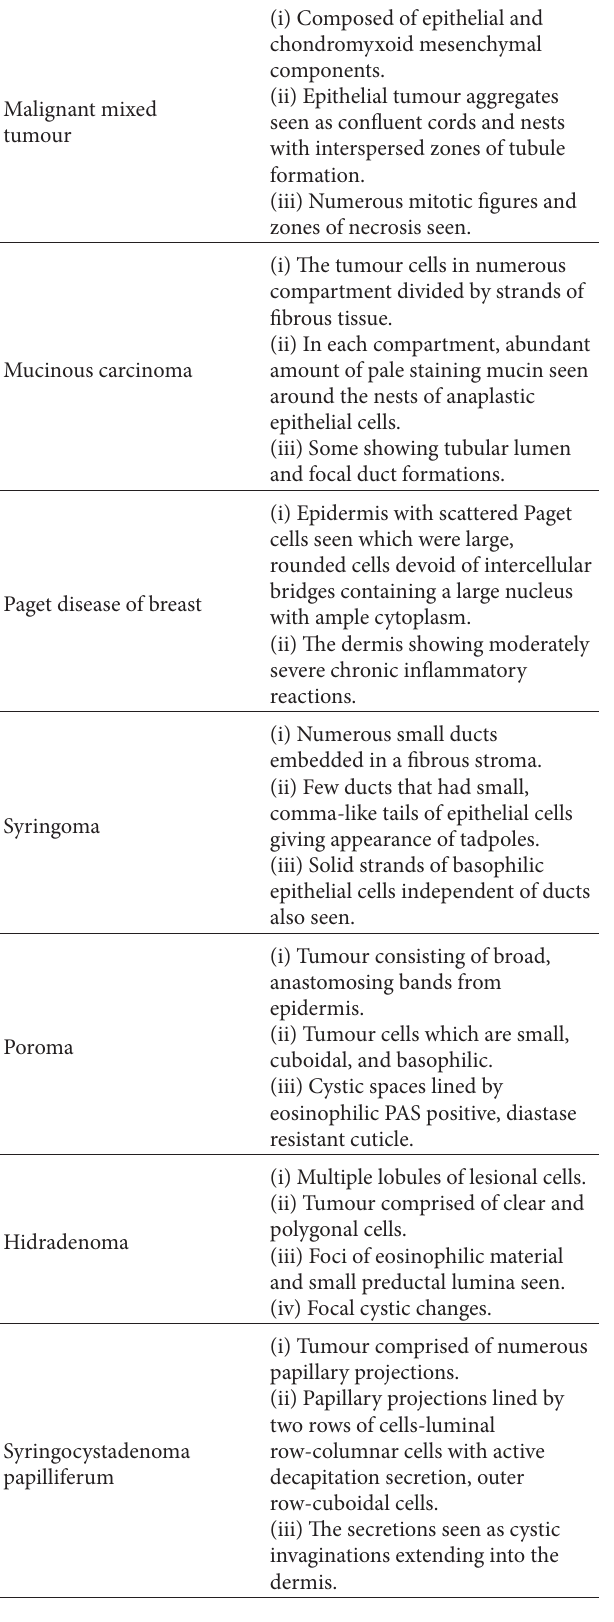
Table 6: Salient histopathological features of eccrine and apocrine tumours.